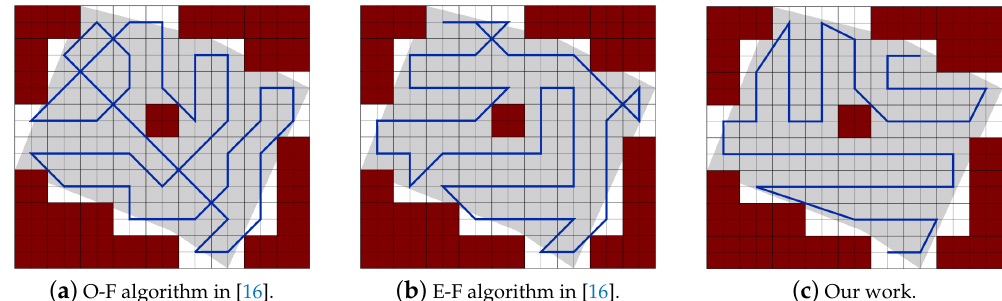
Figure 32. Paths generated by the two algorithms in [16] and by our algorithm.